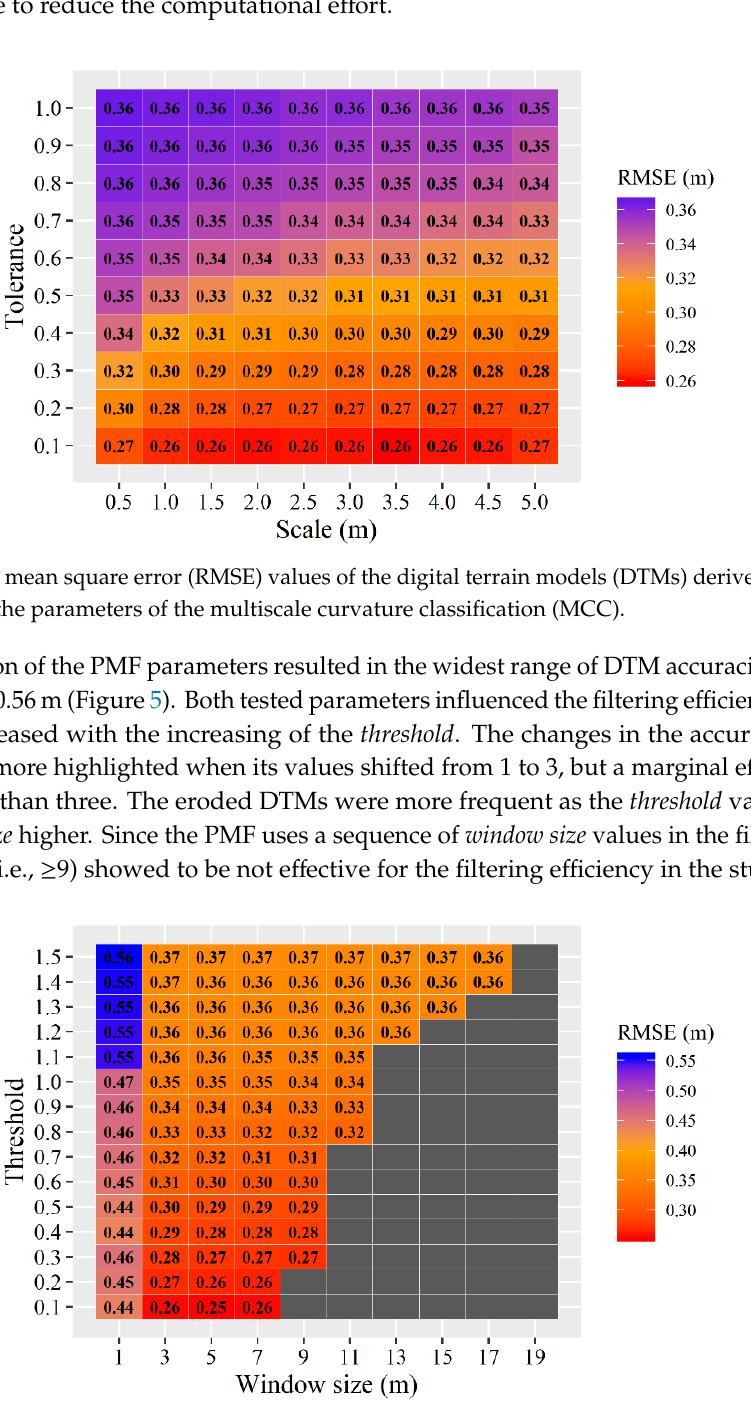
Figure 5. Root mean square error (RMSE) values of the digital terrain models (DTMs) derived from the calibration of the parameters of the progressive morphological filter (PMF). Grey tiles represent settings that produced eroded DTMs.